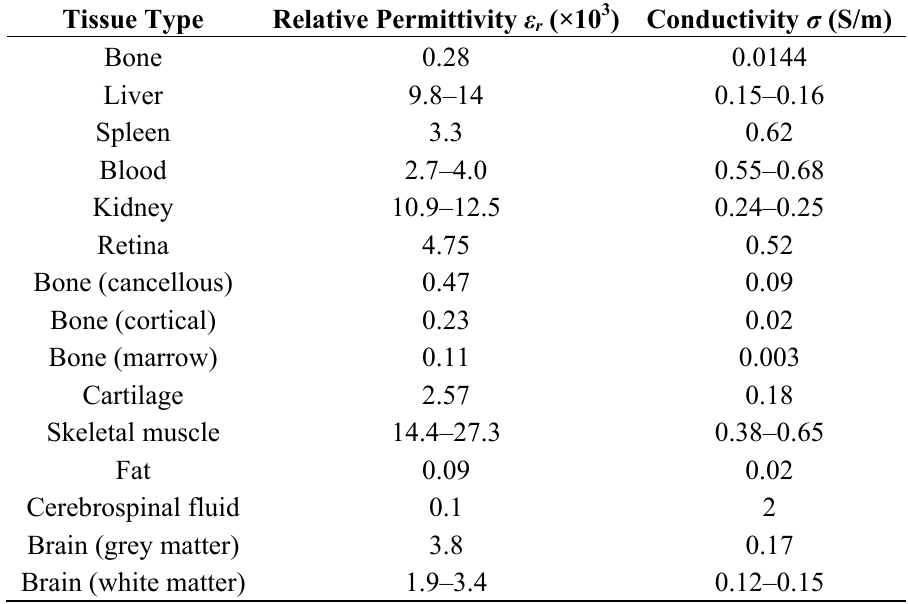
Table 1. Dielectric properties of tissues 1